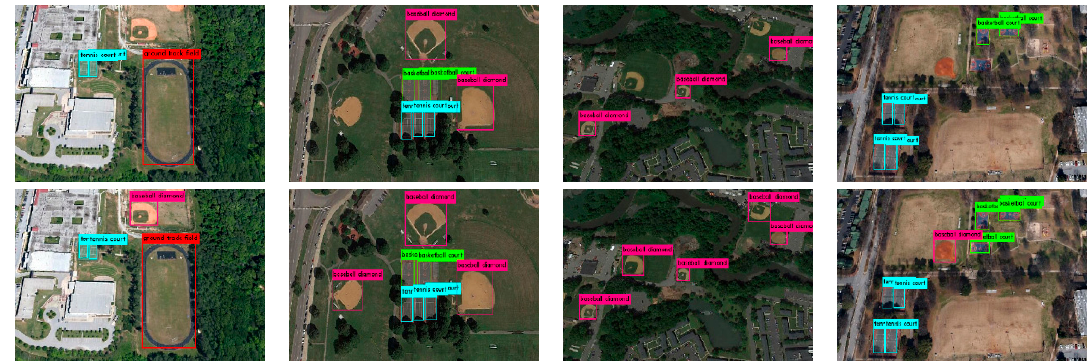
Figure 8. Visual comparisons of detection results between the classical YOLOv3-tiny method (the first and third rows) and the TF-YOLO method (the second and fourth rows).